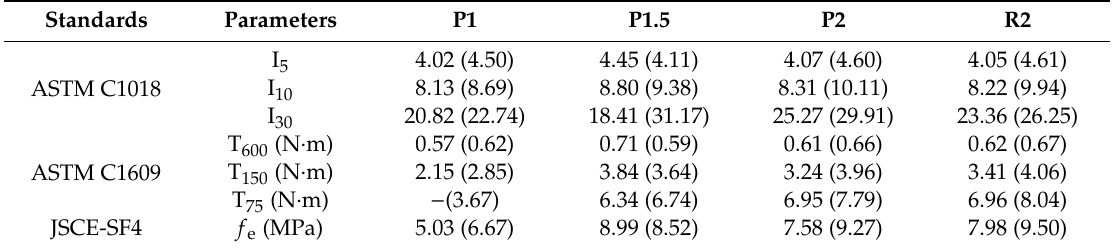
Figure 11. Fractural properties: (a) fracture energy and (b) ductility index of NPFRCCs at seven days and 28 days. Table 4. Flexural toughness parameters in four-point (4-P) bending test. Table 4. Flexural toughness parameters in four-point (4-P) bending test.